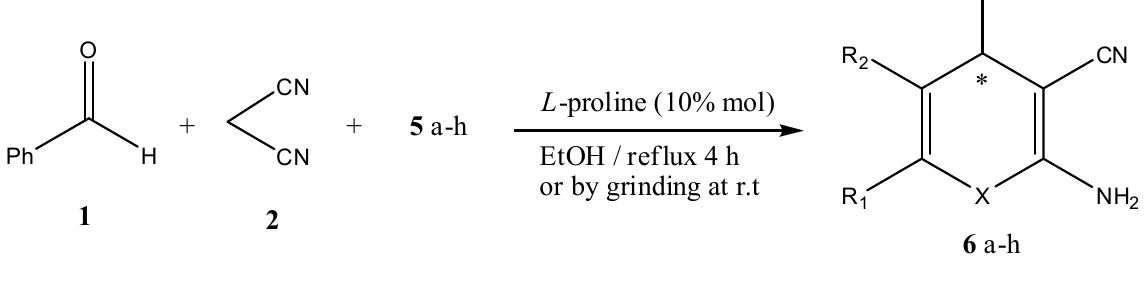
Table 1. Compounds 5a–h